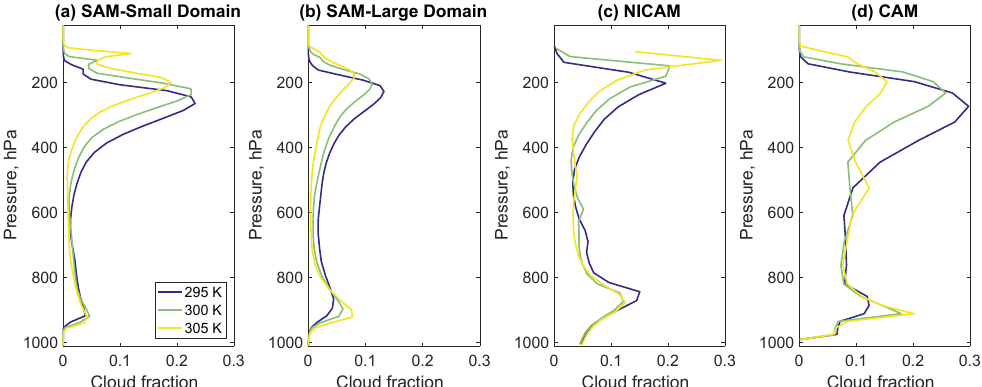
Figure 11. Profiles of total global cloud fraction from the (a) small-domain SAM simulations, (b) large-domain SAM simulations, (c) NICAM simulations, and (d) CAM simulations. The SAM data are averaged over the last 25 days of simulation, the NICAM data are averaged over the last 20 days of simulation, and the CAM data are averaged over the last 2 years of simulation. Note that the NICAM simulations do not precisely follow the RCEMIP protocol, and the NICAM simulations labeled 295 and 305K are actually performed at surface temperatures of 296 and 304K, respectively.